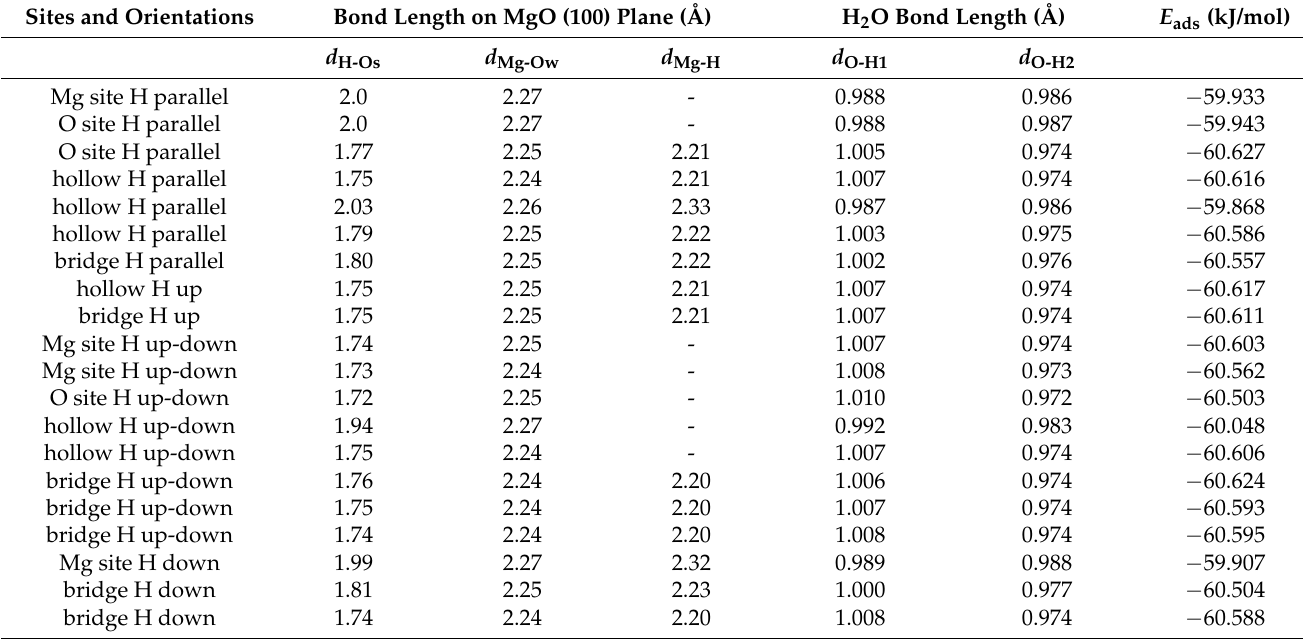
Table 2. Structural parameters and adsorption energy of monomolecular water adsorbed on MgO (100) plane with different